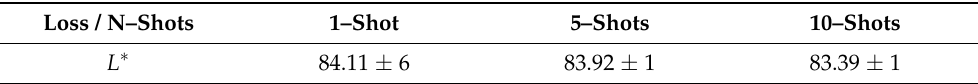
Table 2. MAML 2 nd experiments, average L ∗ over the last 300 episodes of test tasks T v evaluation, averaged over 3 repetitions with 95% confidence